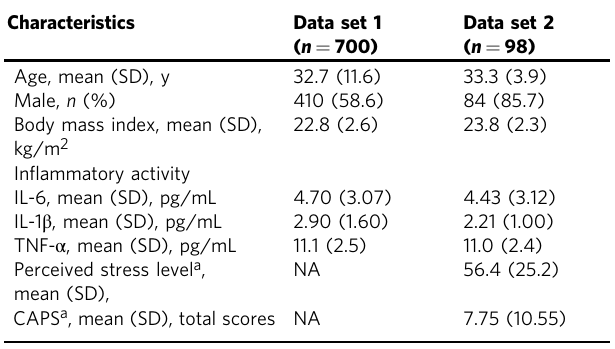
Table 1 Demographic and clinical characteristics of data